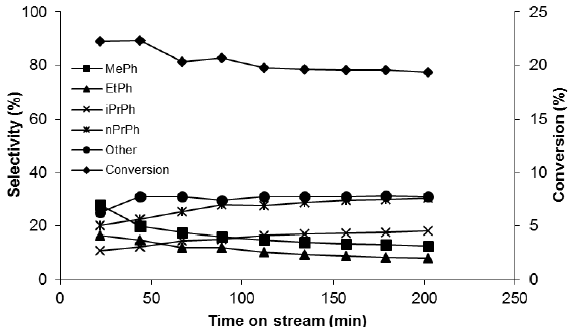
Figure 1. Effect of Pd loading on benzene conversion for benzene alkylation at 300 °C over (1) 7.1%Pd/C + HZSM ‐ 5 catalysts and (2) Pd ‐ HSiW including physically mixed catalysts 7.1%Pd/C + 25%HSiW/SiO 2 (solid diamonds) and supported catalysts Pd/25%HSiW/SiO 2 (open diamonds) (for reaction conditions, see Tables 1 and 2).